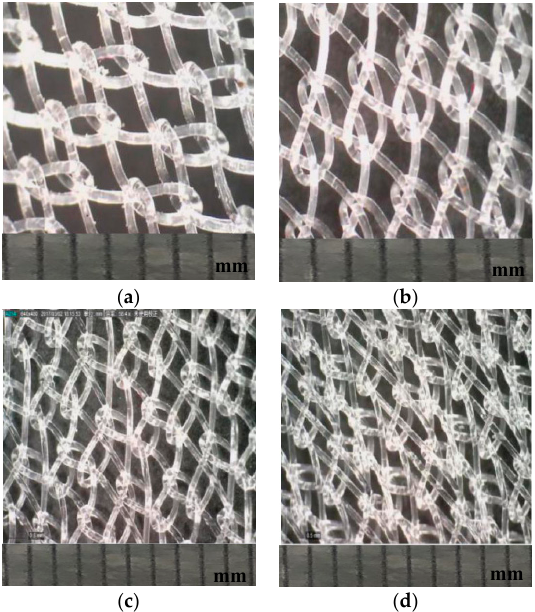
Figure 2. Actual knitted ( a ) fabric 1#; ( b ) fabric 2# ( c ); fabric 3# and ( d ) fabric 4# produced from stitch pattern (one scale value represents one millimeter).